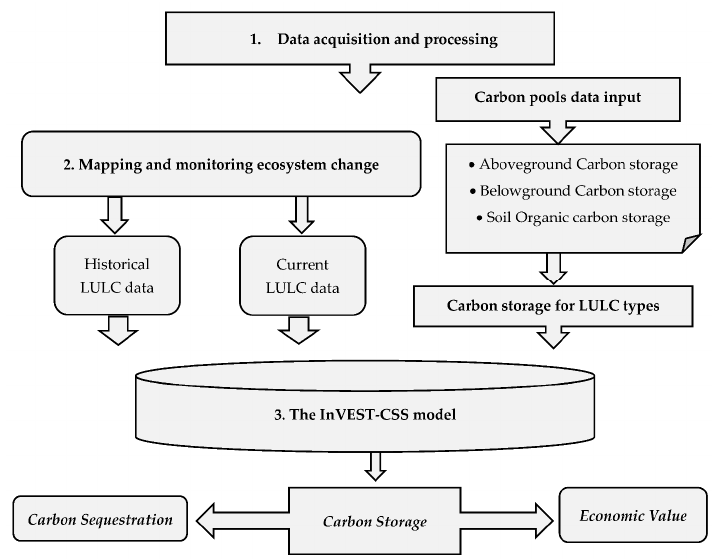
Figure 2. Flowchart of the method used in this study . 2.3. Data Acquisition and Processing InVEST model required (i) data on land use and land cover changes over time, which were obtained by visual interpretation of two high-resolution satellite images (Google Earth and Landsat Thematic Mapper); and (ii) data on carbon in four carbon pools above- ground biomass, belowground biomass, soil biomass, and dead carbon matter [45–47]. To estimate carbon storage in each grid cell, the maps of land use/land cover types were as- sociated with the carbon pools. Data were processed using the thematic mapper for the maps of 1999 and the orthophotos of 2019. The carbon pools included the aboveground biomass and encompasses all living plants above the soil; the belowground biomass com- prises the living roots of all the aboveground biomass; the soil organic matter contains the organic components of the soil; and the dead organic carbon includes the litter and lying and standing dead wood. The values of carbon density in the different LULC habitats used in this study were collected from InVEST database and related research from the literature. The data sources used in this study are listed in Table 2.